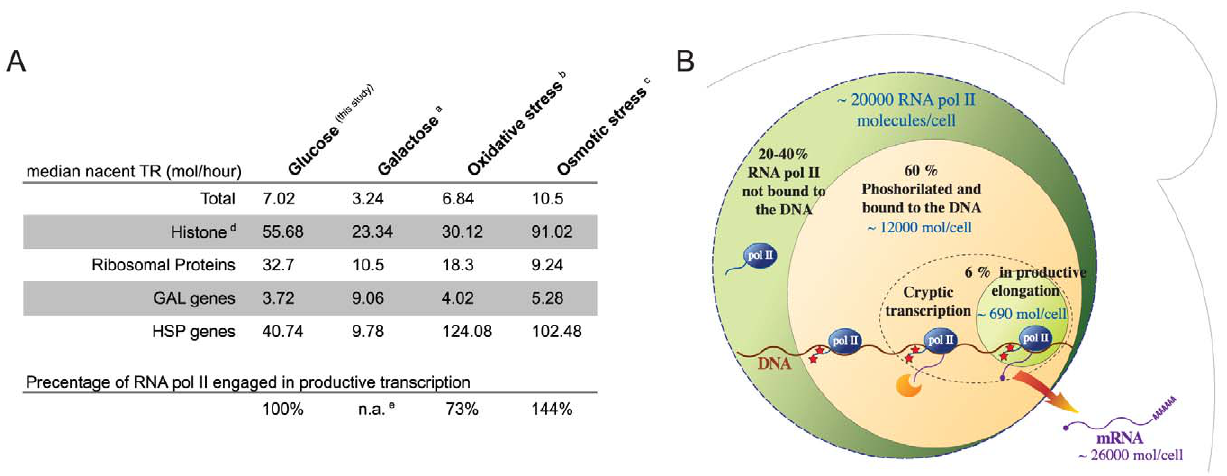
Figure 4. A snapshot of the yeast transcriptome. A) Selected data from the yeast nascent TR dataset. It is shown the median values for the TR for some selected groups of genes in exponential growth in YPD (glucose, this study) as well as in different conditions using previously published GRO datasets normalized with the newly computed nascent data: a cells growing exponentially in YPGal, (galactose: time 5 from [10]); b 16 min after the oxidative stress due to the addition of 0.1 mM t-BOOH [36] c 10 min in 0.4 M NaCl [37]. It is also shown the percentage of RNA pol II engaged in productive transcription (total transcription activity) relative to the exponential growth in glucose. e In the case of yeast cells growing in galactose this percentage is not significant because it is not possible to assume that the total amount of RNA pol II has not changed after several cell cycles using galactose as carbon source. On the other hand, we assume that the total amount of RNA pol II has not change during the short stresses. B) Schema of the yeast nucleus showing the computed distribution of transcriptional machinery during the exponential growing in rich medium. The size of the respective circles reflects the amount of RNA pol II molecules in each category.